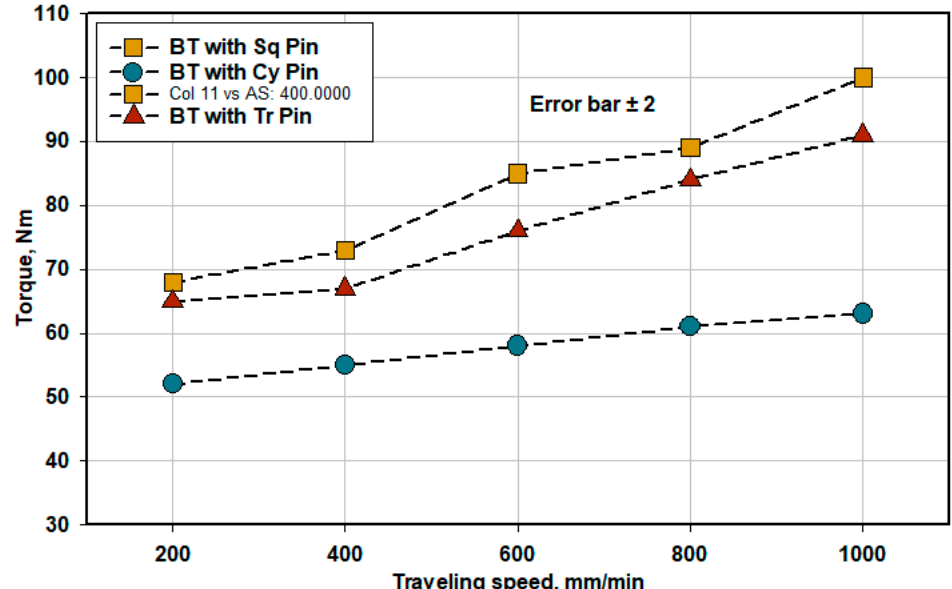
Figure 10. Torque during BT-FSW of AA1050-H14 with various pin geometries.